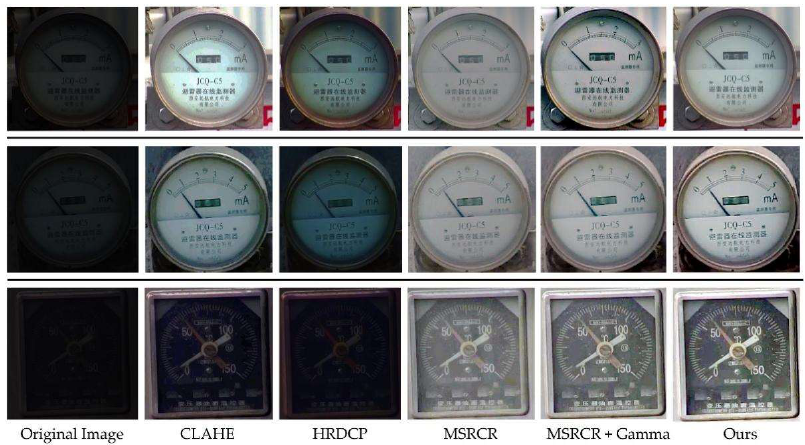
Figure 9. Comparison of the effect of each light enhancement algorithm.